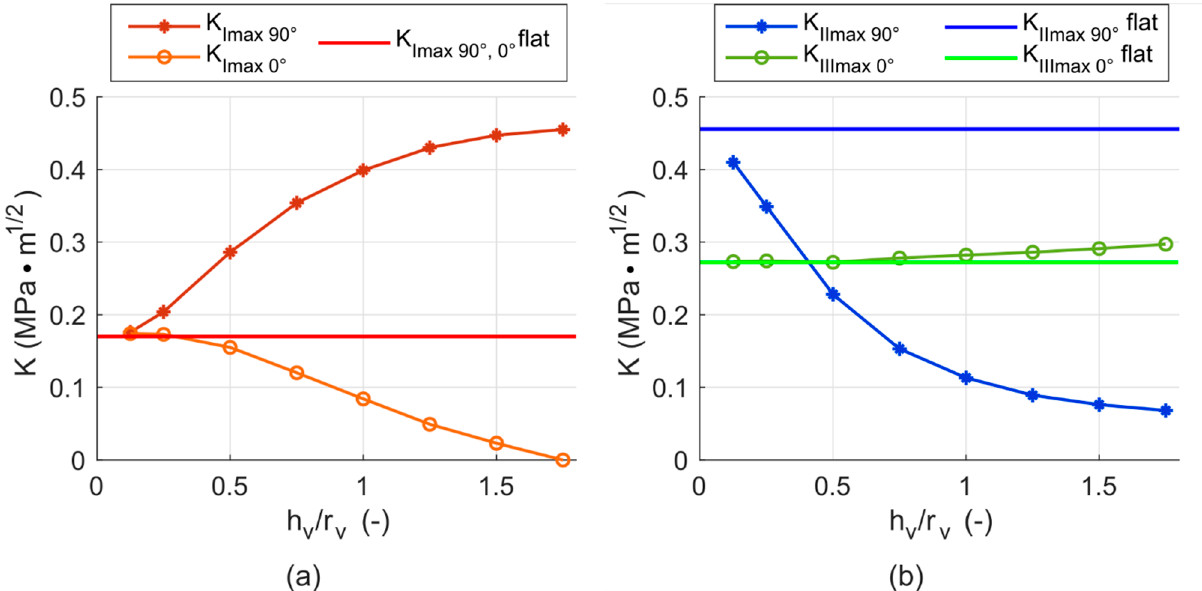
Figure 14. ( a ) Change of K Imax in different crack tip positions depending on the varying void ratio h v / r v ; ( b ) Change of K IImax and K IIImax depending on the void ratio. Both plots contain the value of K Imax 90°,0° , K IImax 90° and K IIImax 0° for the case of flat crack a = 0.85 mm plotted as a solid line for comparison.